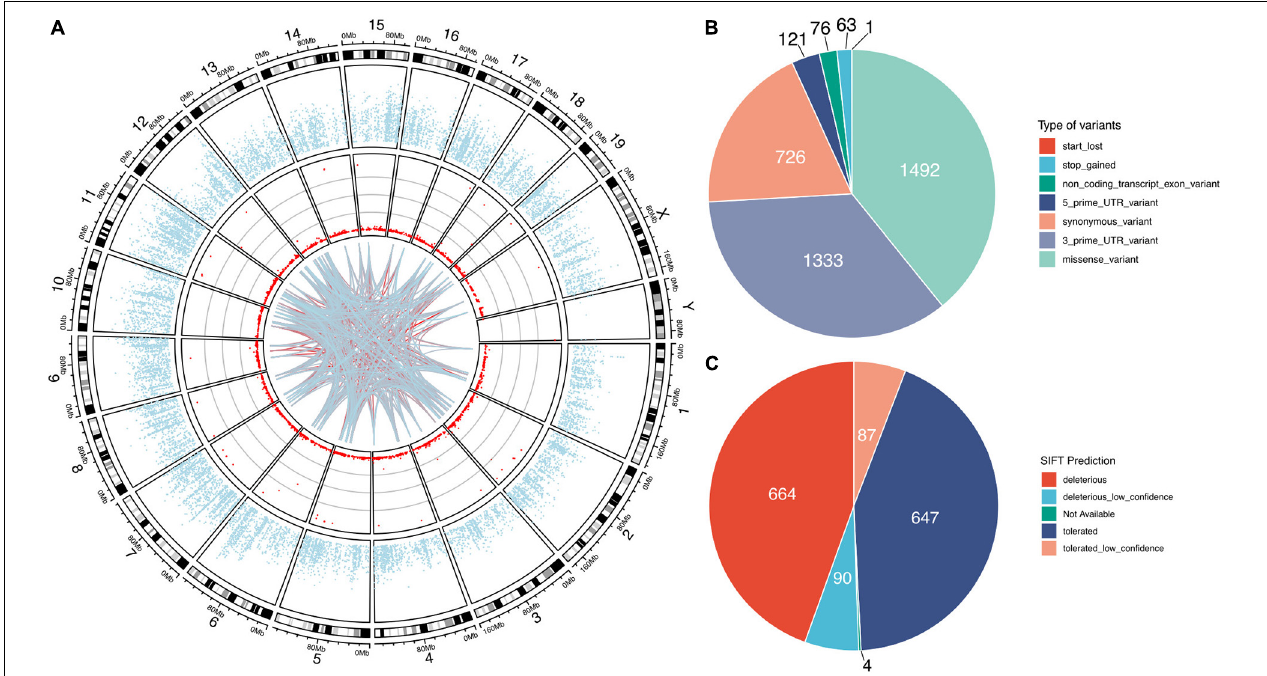
FIGURE 1 | G-to-A RNA editing events identified from adult mouse VTA transcriptome. The red dots denotes the events observed across all chromosomes in the mouse genome (A) . The blue dots show mean expression levels of genes. And the lines denote interaction between the G-to-A RNA editing events, with the blue-to-red gradient indicated the correlation co-efficient r. The interaction among the top 100 frequently observed editing events is shown. (B) The G-to-A RNA editing events result in various types of mRNA variants. (C) About half of these missense events are predicted by SIFT to possibly be deleterious on the encoded proteins.